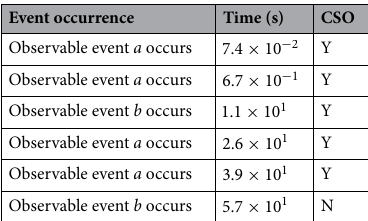
Table 1. Performance of Algorithm 2.